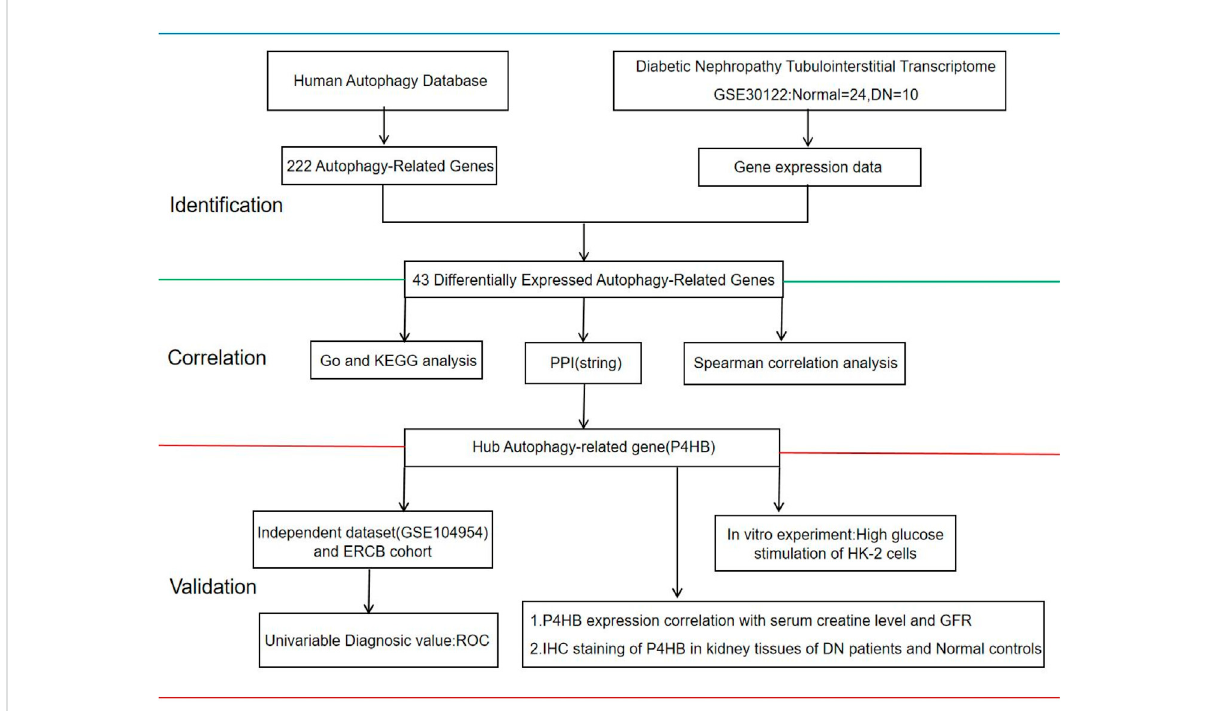
FIGURE 1 Work fl ow of this study. The gene expression of human renal tubulointerstitial data was extracted from the GEO database (GSE30122). GEO, Gene Expression Omnibus; Normal, healthy controls; DN, patients with diabetic nephropathy; GO, Gene Ontology; KEGG, Kyoto Encyclopedia of GenesandGenomes;PPI, protein – proteinInteraction;ERCB:EuropeanRenalcDNABank;ROC,receiveroperatingcurve;GFR,glomerular fi ltration rate; IHC,